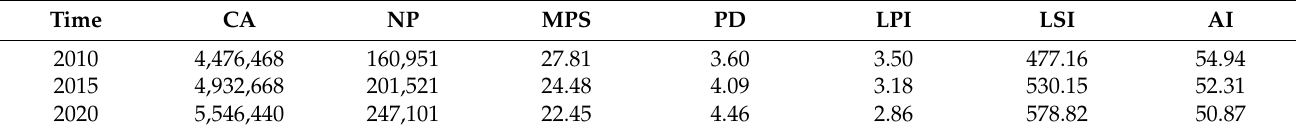
Table 2. Changes in landscape indicators of national moso bamboo forests.